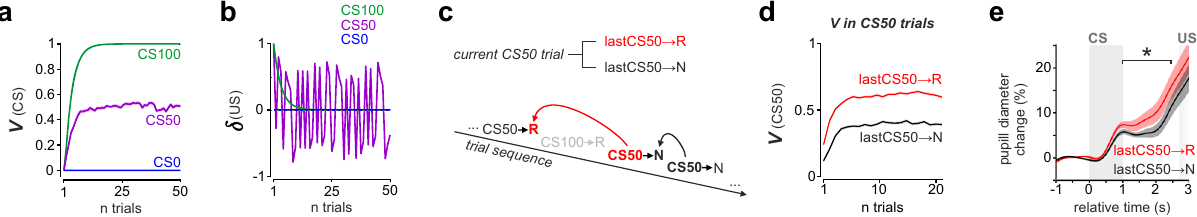
Fig. 2 Fluctuations in pupil dilation re fl ect cue-speci fi c value update by recent reward history. a Averaged RP values V ( CS ) of the three CS from the TD model ( n = 100 simulated CS-US sequences, learning rate α = 0.28 optimized from pupillary data, initial conditions set to zero). The values approached the true reward probabilities associated with each CS. b The prediction error δ at US approached zero in CS100 and CS0 trials, while it remained large in CS50 trials as shown here for an exemplary session. c Scheme illustrating the subdivision of CS50 trials for recent outcome-history analysis. CS50 trials were grouped according to the outcome of the previous CS50 trial (rewarded: lastCS50 → R; unrewarded: lastCS50 → N). d Average modeled V ( CS ) for CS50 trials divided according to lastCS50 → R and lastCS50 → N predicts a dynamic update of RP based on the recent outcome history. e Average change ± SEM of the normalized pupil diameter in CS50 trials split for lastCS50 → R and lastCS50 → N. The change in pupil diameter during waiting followed the recent history update (two-tailed paired t test). In the fi gure: * indicates P < 0.05 (see Supplementary Table 1 for exact P values and test